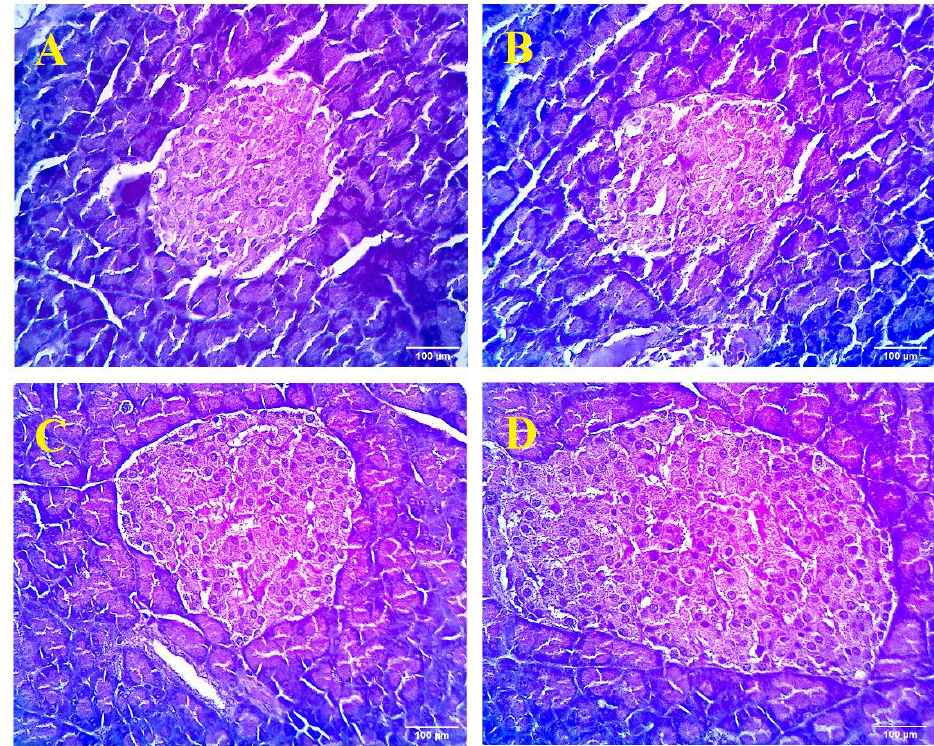
Figure 3. Light microscopic examination of pancreatic tissue (stained by hematoxylin and eosin stain) obtained from various experimental groups. ( A ): Normal group showing normal appearance of the pancreas; ( B ): Diabetic group revealed pathological changes in parenchymal cells of pancreatic tissue; ( C ): Diabetic rats treated with glibenclamide displaying restoration of the general architecture; and ( D ): Diabetic rats treated with Punica granatum (600 mg / kg) showing nearly normal architecture of pancreas.